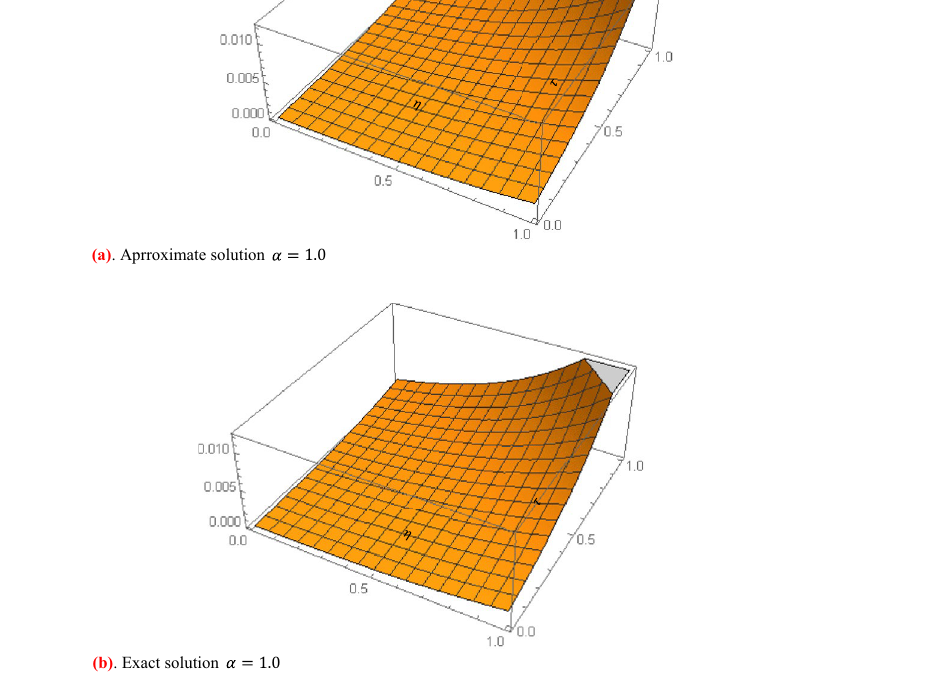
Figure 4. 2D plots obtained by the suggested process for FZK(2,2,2) at y = 0.2 and τ = 0.1